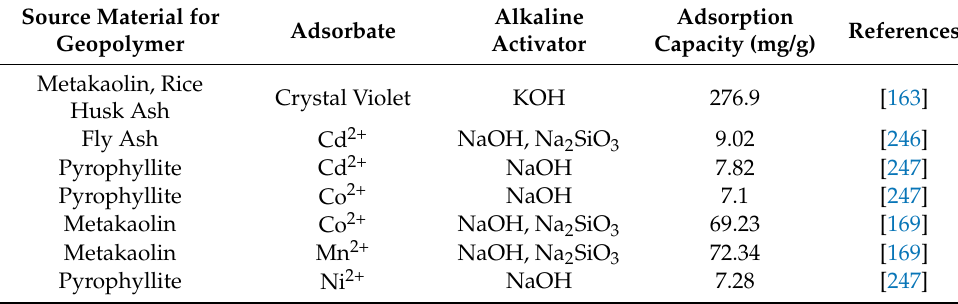
Table 1. Adsorption of metals through a